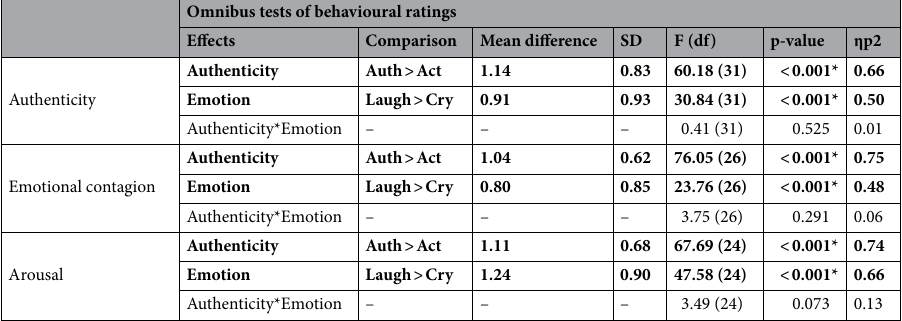
Table 1. Summary of the main effects and interactions of authenticity and emotion category on authenticity, emotional contagion, and arousal ratings. Auth authentic, Act acted. Statistically significant effects (p < 0.05) are signalled with a bold font and an